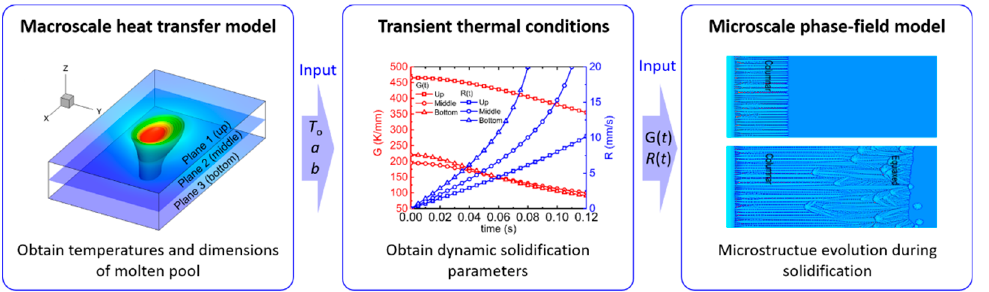
Figure 1. Flowchart illustrating the relationship between macroscale model and micro-scale model.